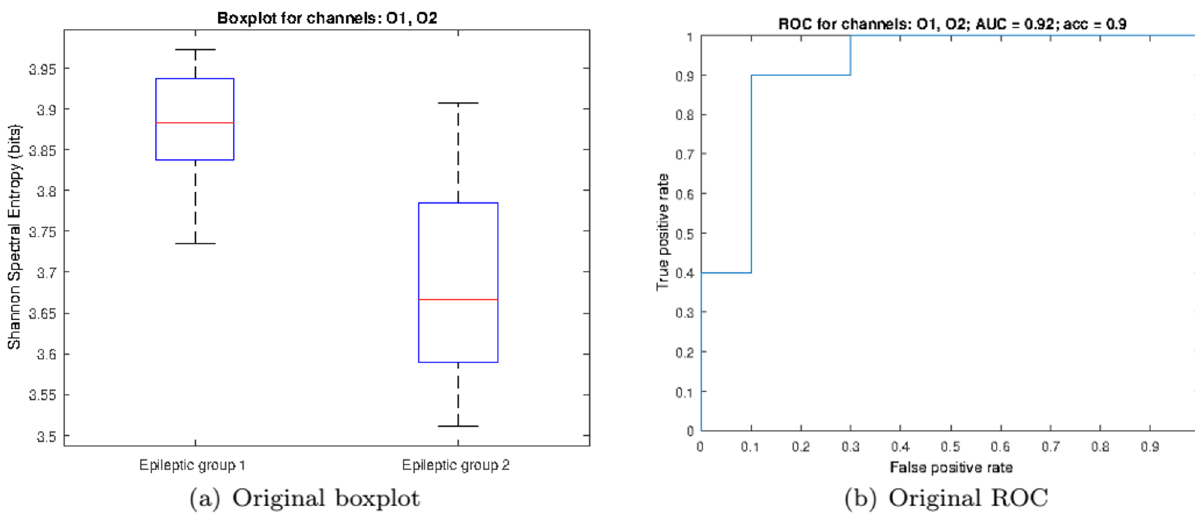
Fig 6. Classification analysis for electrodes O1 and O2. (a) Boxplot and (b) ROC curve corresponding to the classification analysisof the two groupsof epilepticpatients using values from channelsO1 and O2. Red lines in the boxes mark the medianand edges the 25th and 75th percentilesof the data.